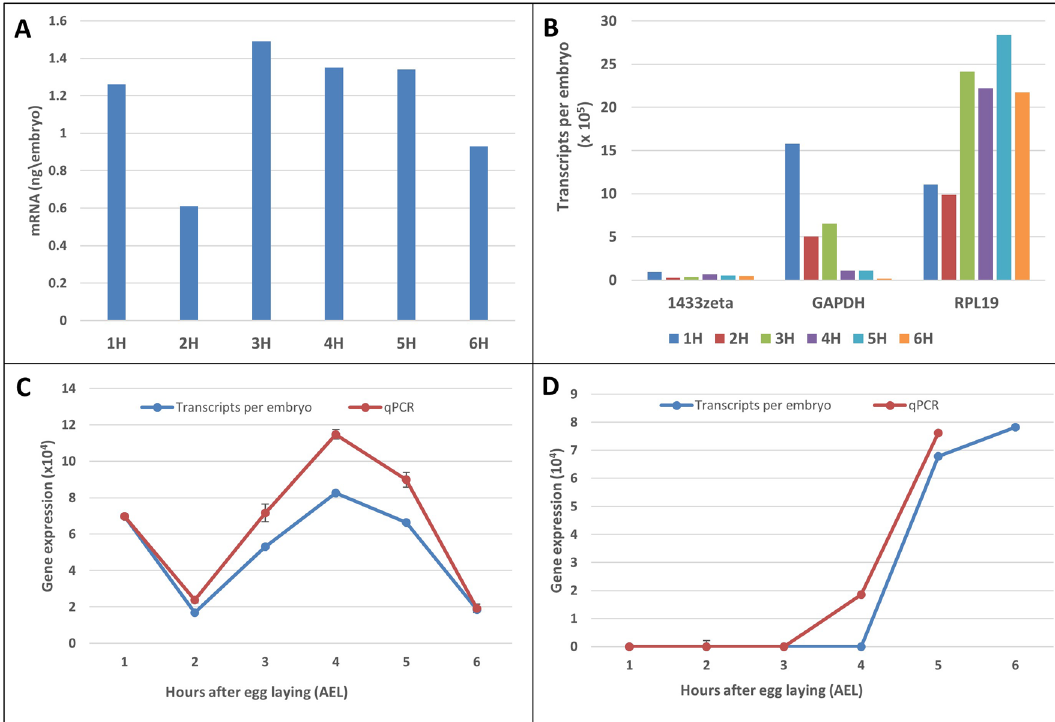
Figure 3. Validation of absolute normalization. ( A ) Total mRNA (ng) per embryo across timepoints derived from conversion of absolute number of transcripts per gene to nanograms. ( B ) Absolute gene expression of 3 genes proposed by Sagri et al. 30 as candidate housekeeping genes ( 14.3.3.zeta , GAPDH , RPL19 ). ( C ) Absolute expression (blue) and qPCR expression (red) of serendipity alpha ( sry ). qPCR expression values were scaled to compare expression profiles. ( D ) Same as C but for head involution defective ( hid ). The reverse